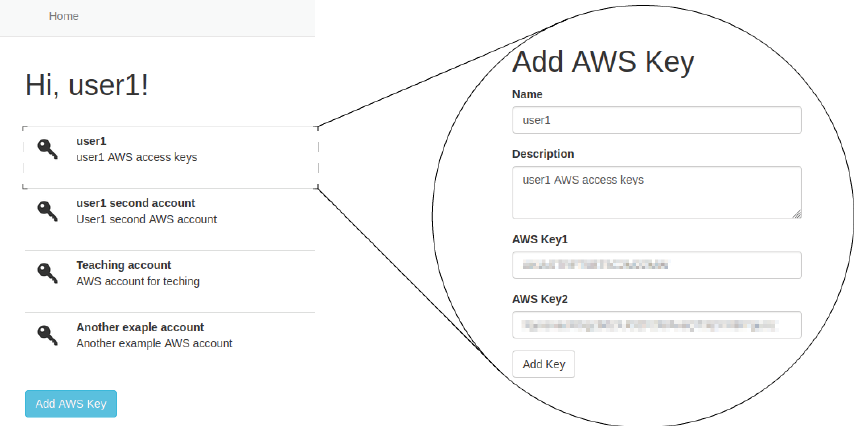
Figure 6. Access key association. On the left side, each user can store several access keys to log in to their cloud account. On the right, the image shows the detail of an example AWS access